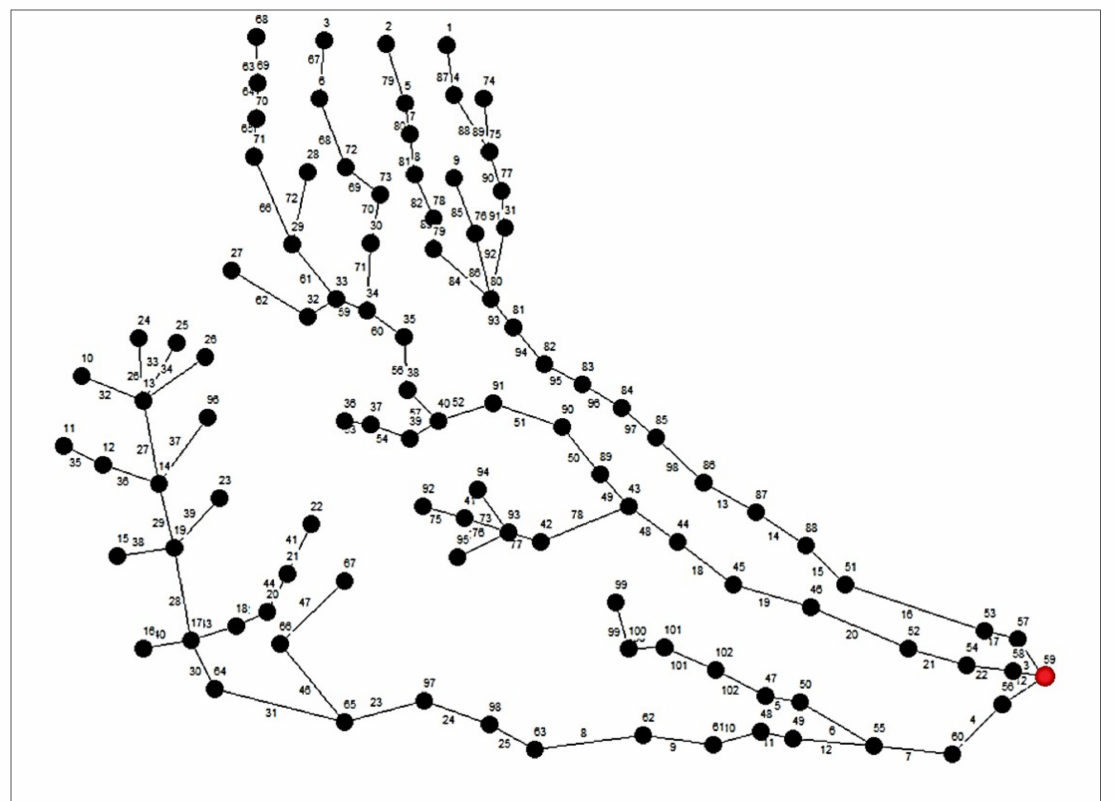
Figure 1. Illustrative wastewater collection